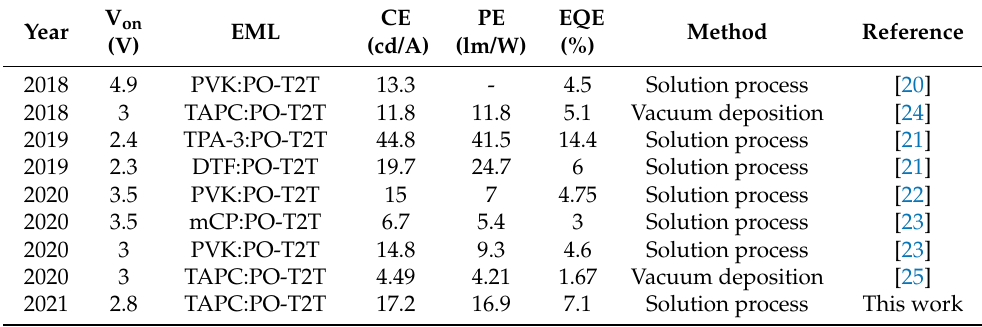
Table 1. Summary of recent reports of donor: PO-T2T based